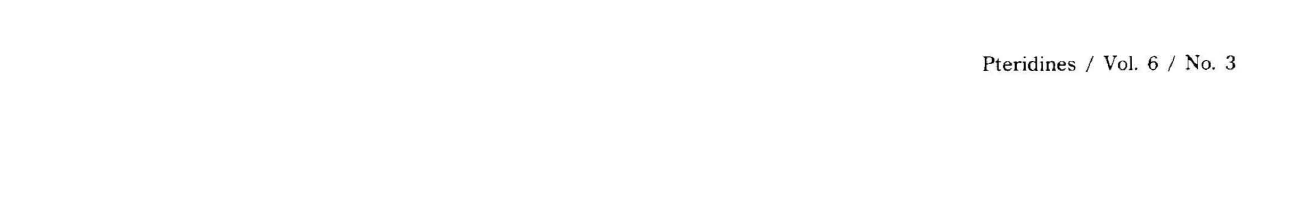
into non-fluorescent products. This indictaes that DH. is bound to protein in the culture medium and